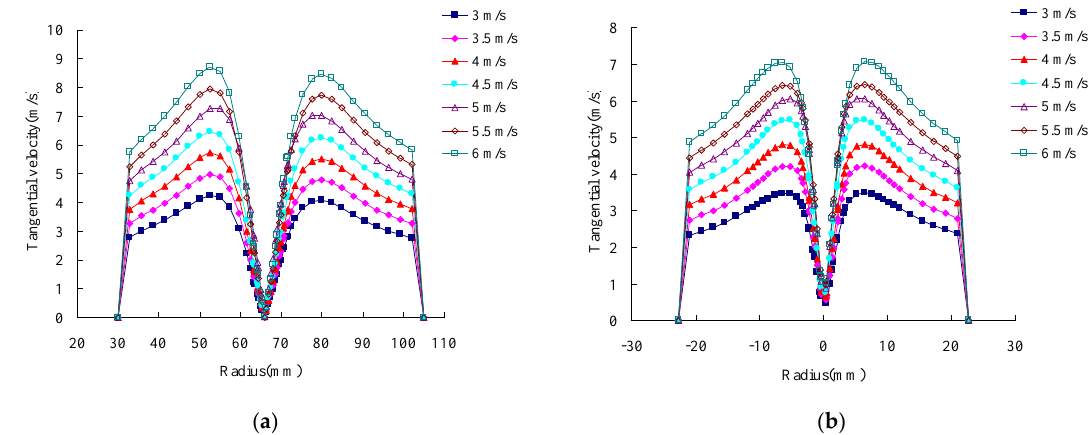
Figure 7. Comparison of tangential velocities: ( a ) Z = 300 mm (first stage); ( b ) Z = 150 mm (second stage).